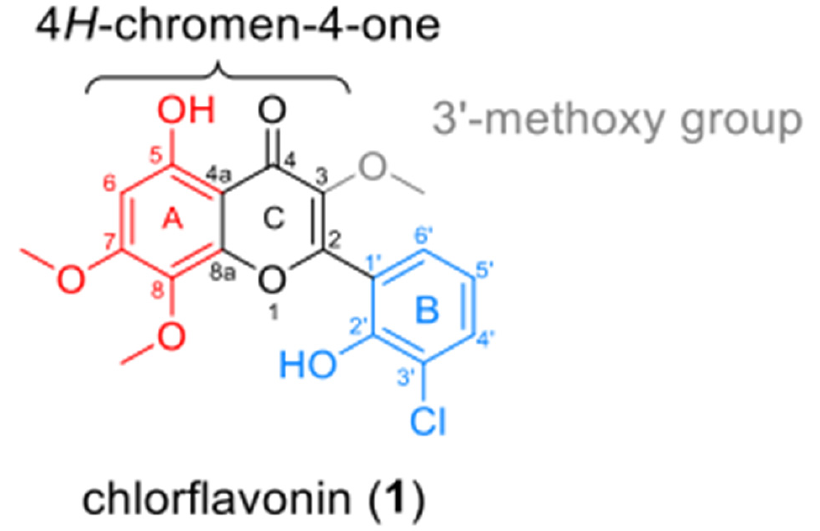
Figure 1. Structure and nomenclature of CF ( 1